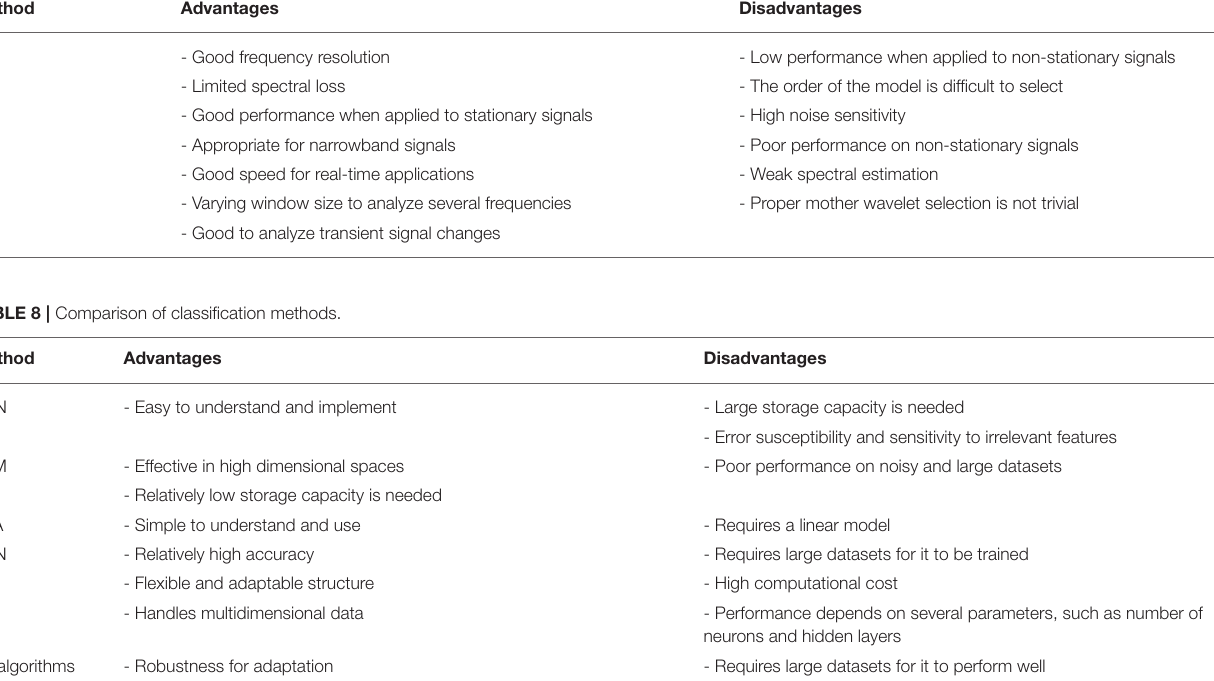
TABLE 7 | Comparison of feature extraction methods. Method